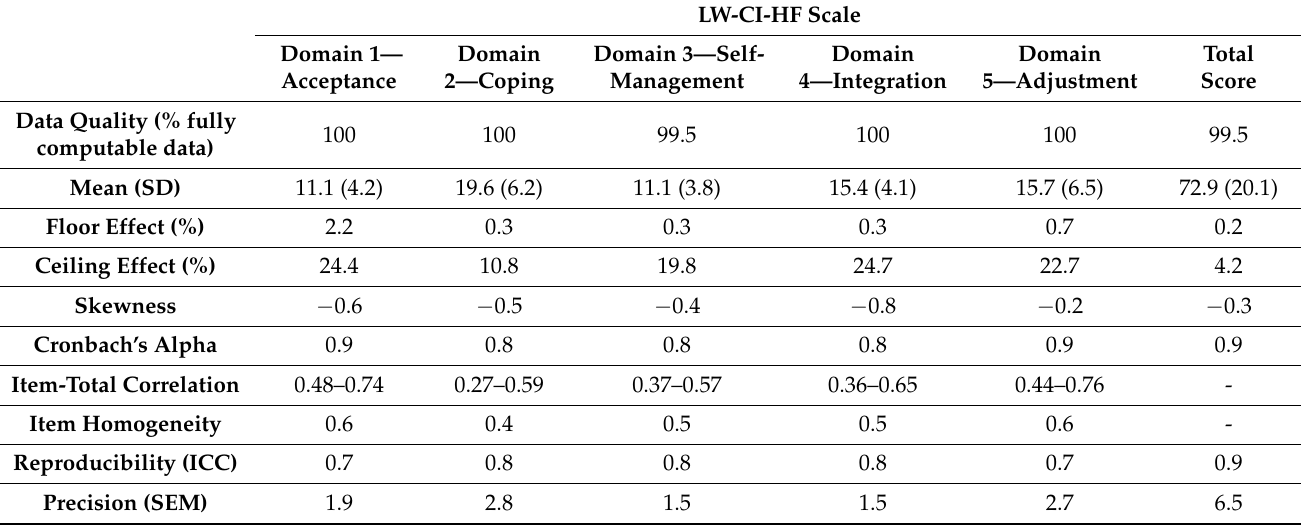
Table 2. Feasibility/acceptability, reliability and precision of the LW-CI-HF